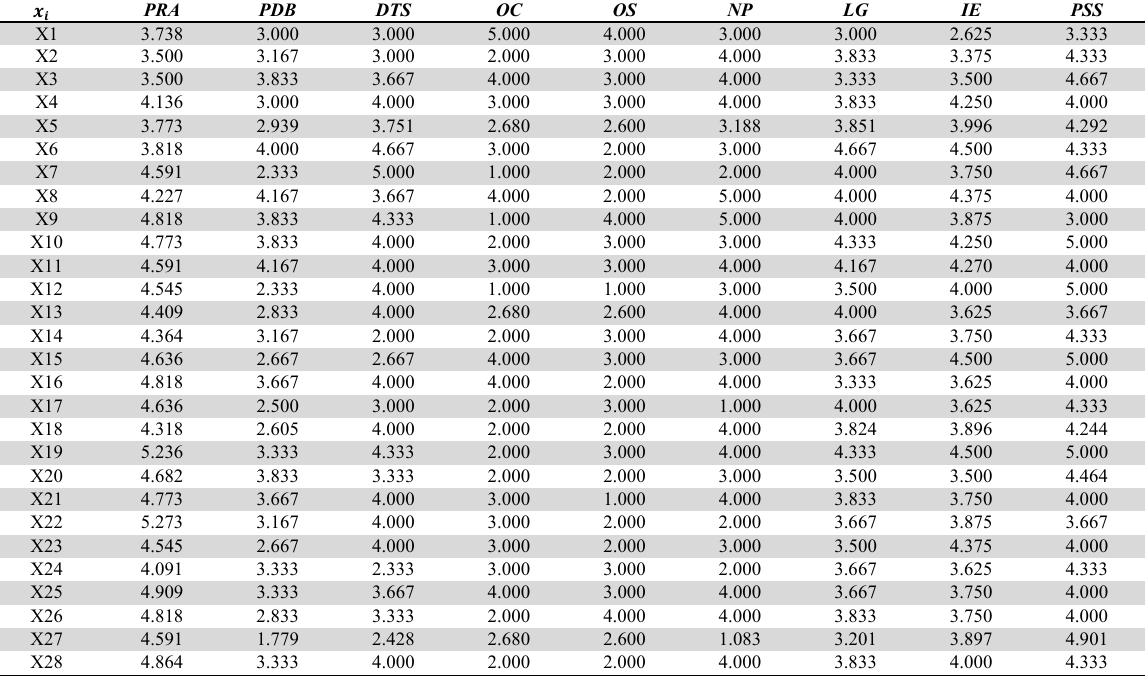
Initial decision-making matrix according to Expert’s opinion on user’s propensity to use, diffuse, and adopt HLDBE 𝒙 𝒊 PRA PDB DTS OC